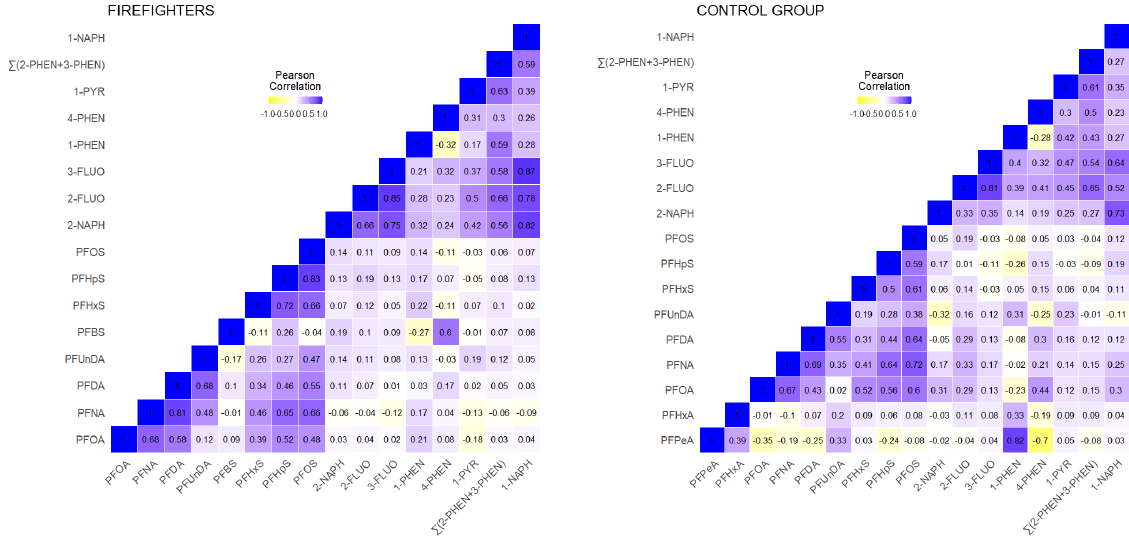
Figure 2. CELSPAC—FIREexpo: heatmap showing the Pearson correlations between serum PFASs and creatinine-standardised urinary OH-PAHs for firefighters ( left ) and the corresponding control group ( right ). Data were corrected for age and